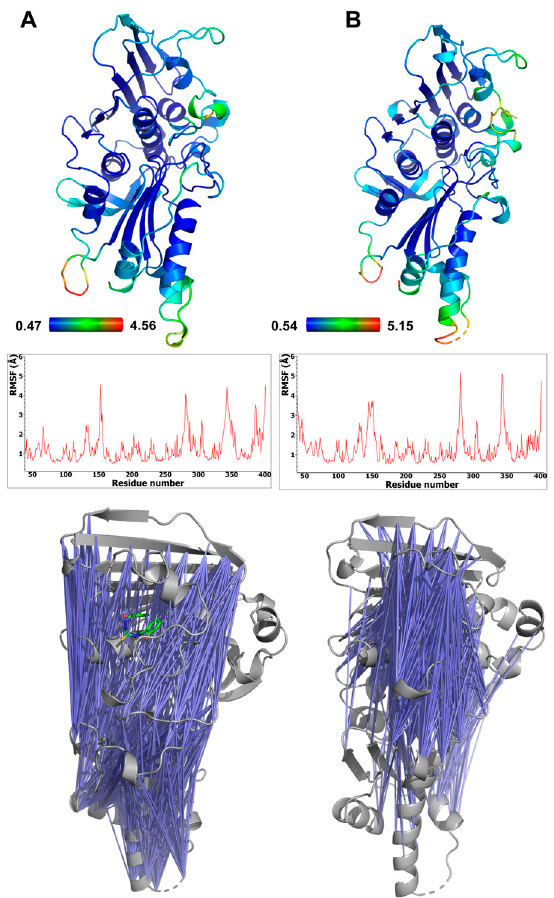
Figure 5. Flexibility of the ATPase domain of human topo II α , depicted as a B-factor representation colored by RMSF values (top) and also shown as RMSF graphs s (middle) for complexes with compound 2 ( A ) and TSC24 ( B ). The bottom panel shows pairs of residues of topo II α ATPase domain displaying anticorrelation movements (correlation coefficients between − 0.4 and − 0.6) (left), topo II α complex with compound 2 , and (right) topo II α complex with compound TSC24